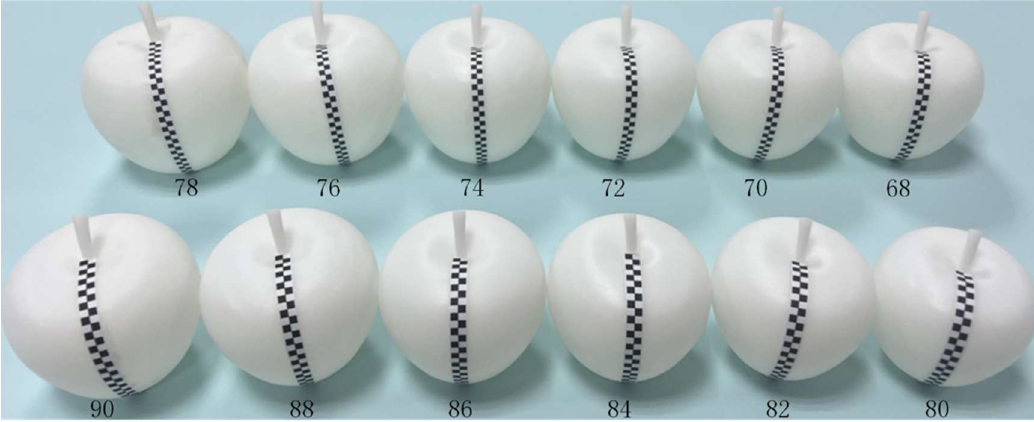
Figure 5. The apple models with labels.